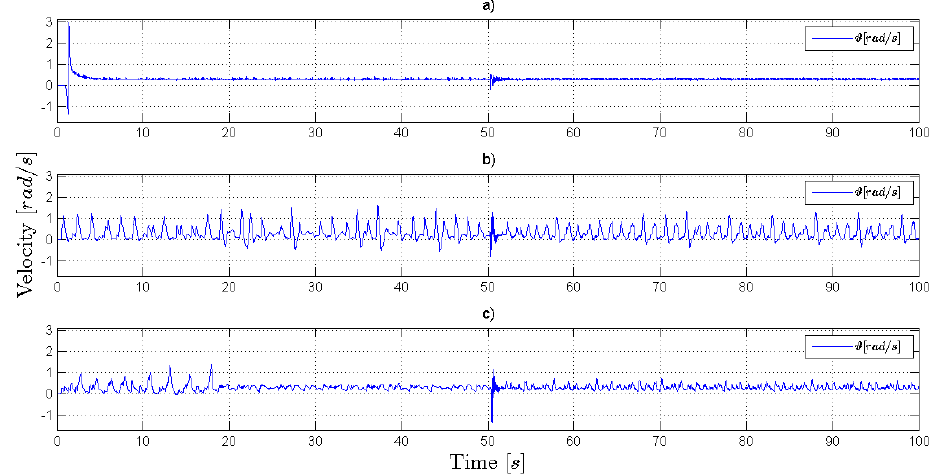
Figure 4. Estimation of the angular velocity when it is controlled to 0.3142 rad/s. ( a ) FSLC as the velocity controller; ( b ) PI as the velocity controller; and ( c ) ANN as the velocity